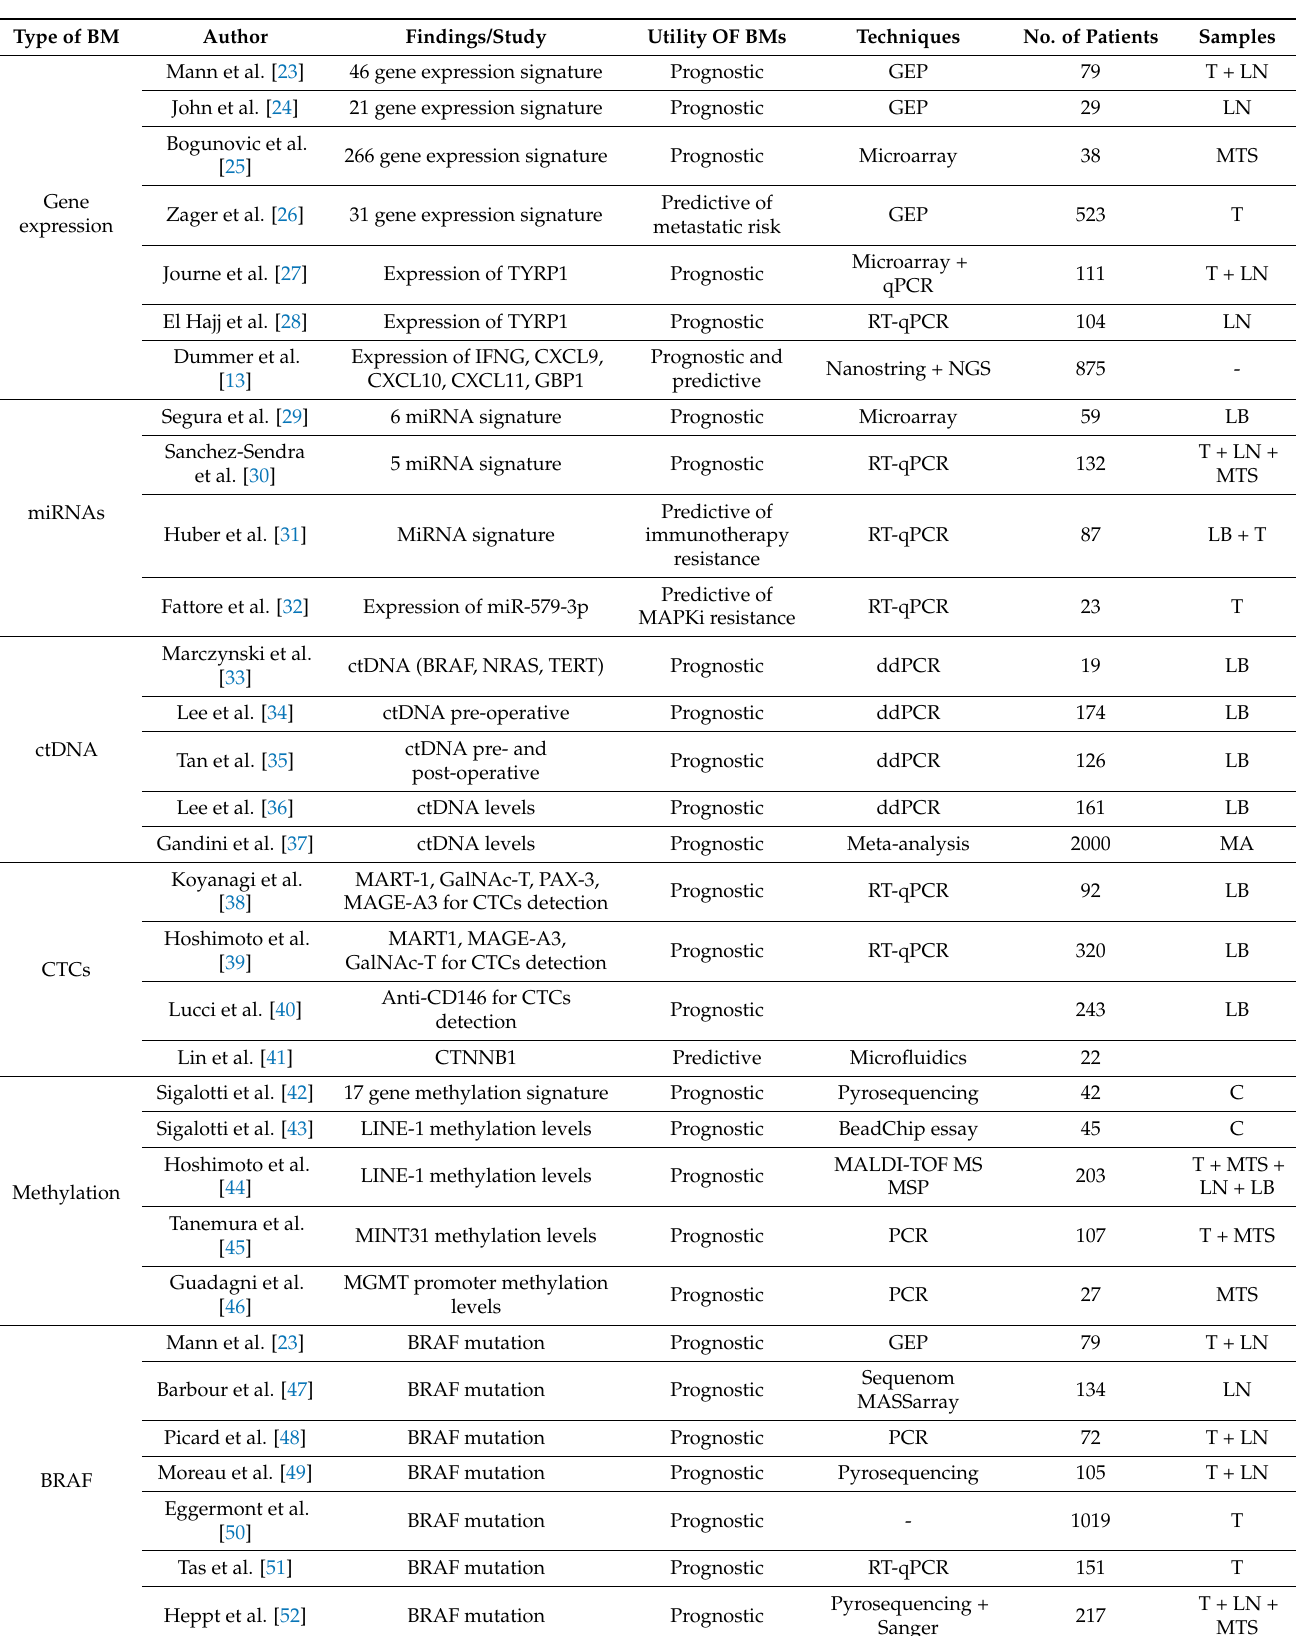
Table 1. Summary of the main biomarkers for stage III